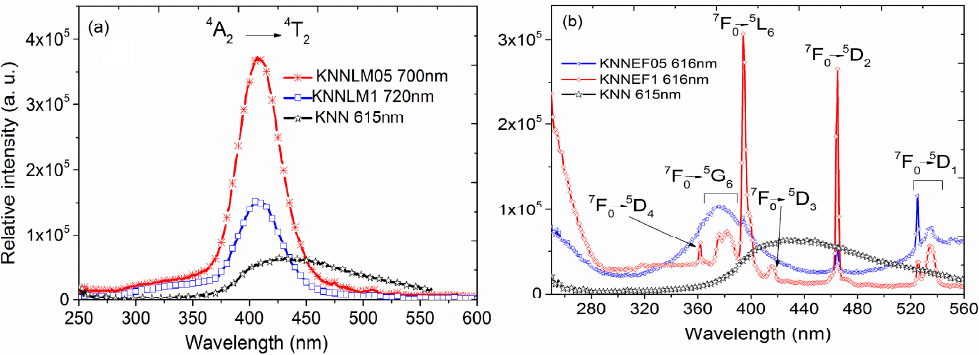
Figure 4. Excitation spectra of the ( a ) La–Mn co-doped KNN compounds and ( b ) Eu–Fe co-doped samples.